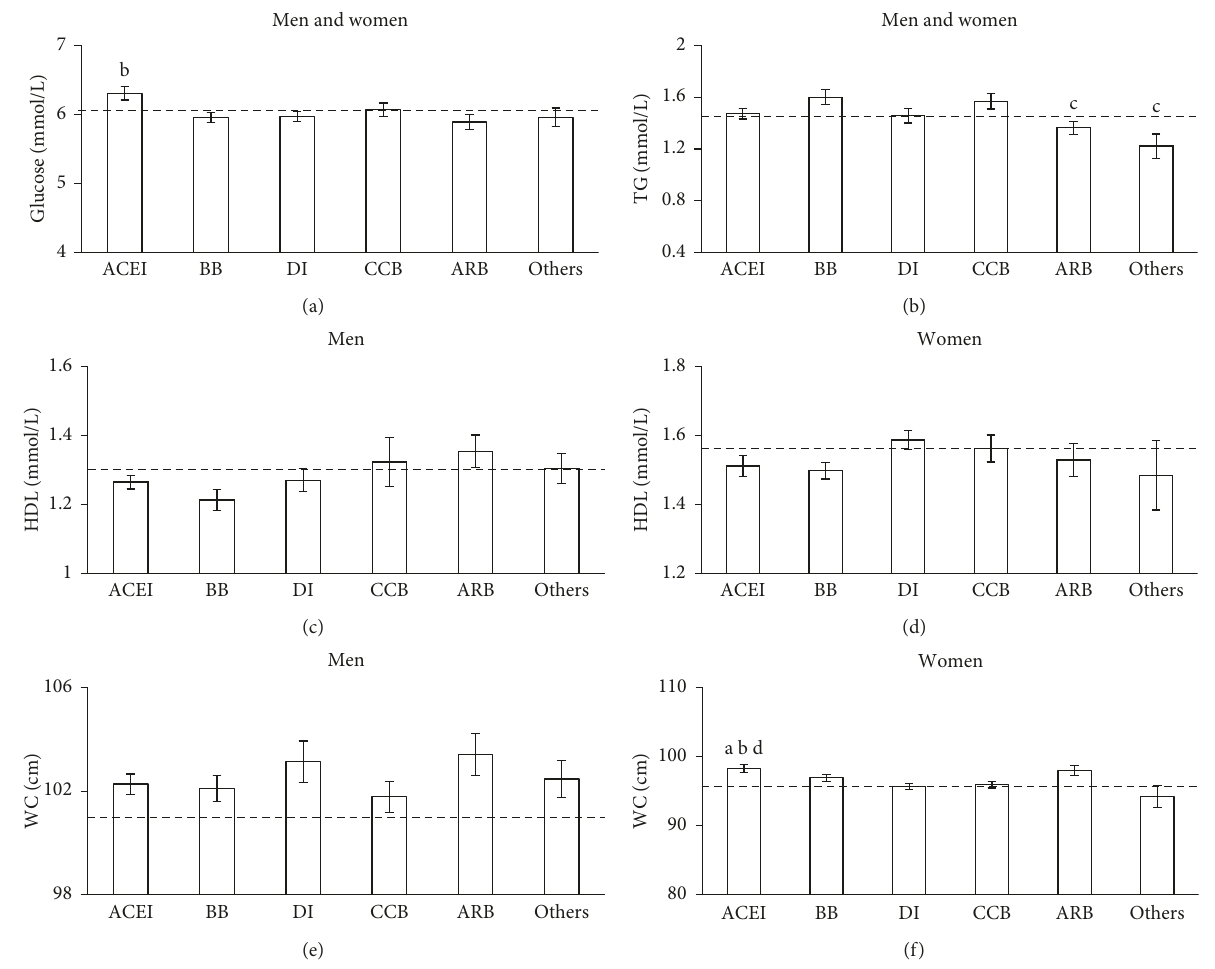
Figure 3: Adjusted means for cardiometabolic risk factors by antihypertensive medication type. All models adjusted for age, gender, BMI, education, health insurance, smoking, and physical activity levels. Further adjustment for type 2 diabetes performed on FPG. ACE inhibitor; BB